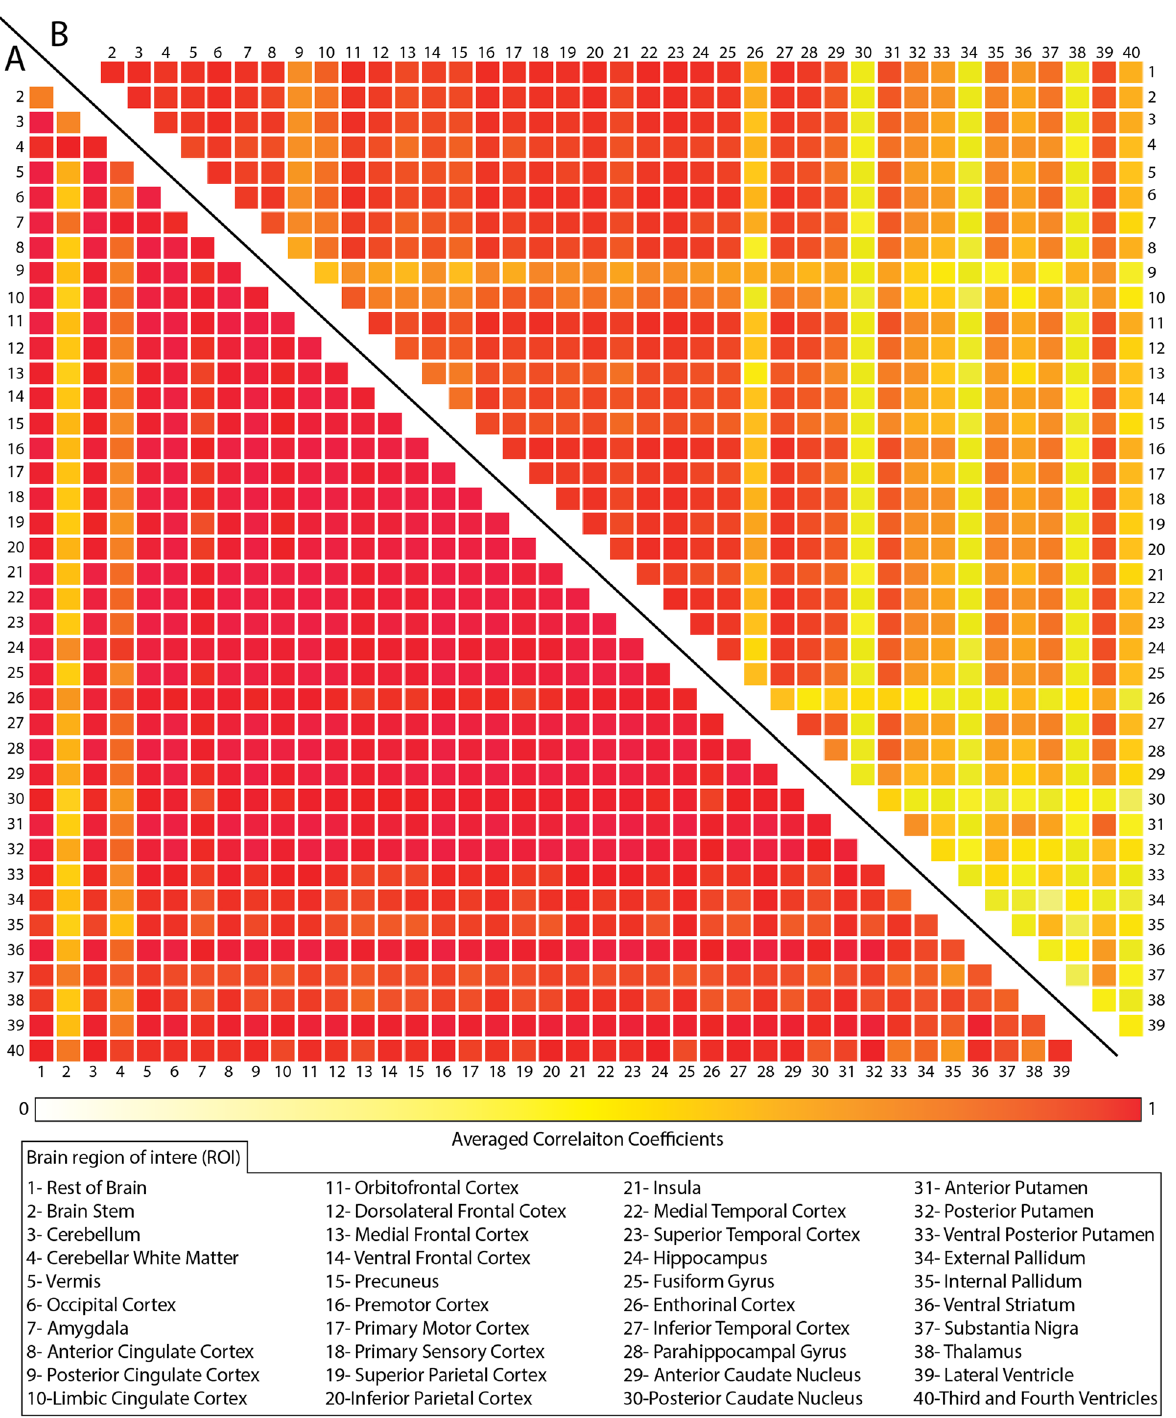
Fig. 4 Confusion matrix analyzing the time and concentration variability of the pharmacokinetics of various brain regions when the catheter tip is placed at C1 ( A ) or T10 ( B ). Each matrix demonstrates the average value across the cohort and the color bar represents the Pearson correlation coefficients. Due to the symmetric nature of the cross-correlation analysis between ROI-pairs, the lower half of each matrix was not included. A value of 1 along the x-axis denotes regions of highest similarity, while a value of 0 denotes regions of least